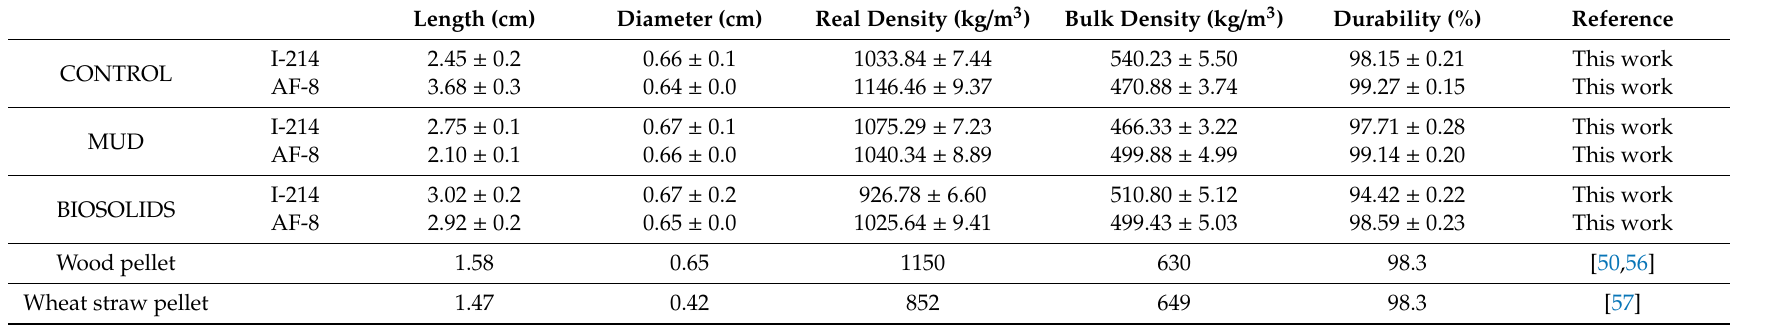
Table 1. Physical and mechanical properties of pellets.